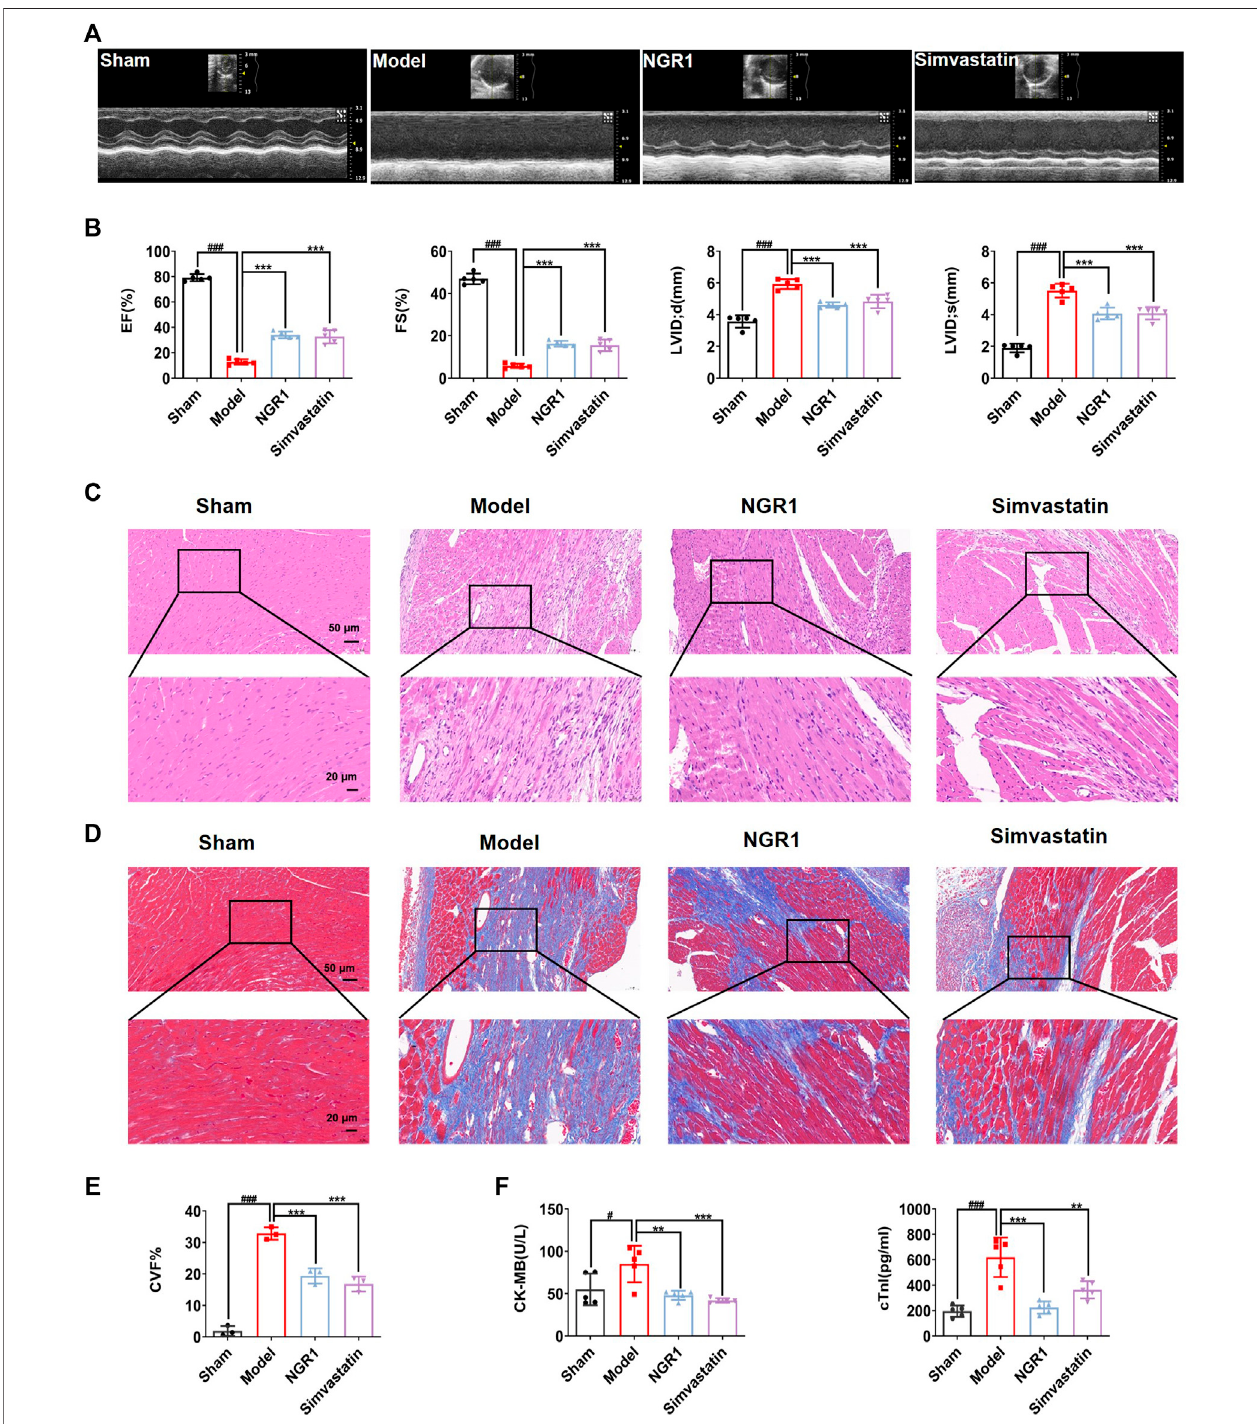
FIGURE 1 | NGR1 treatment enhanced cardiac function and alleviated myocardial pathological changes in the HF mice model. (A) Representative images of 2M- modeechocardiographyinthesham,model,NGR1andsimvastatingroup. (B) Quantitativeanalysisoftheejectionfraction(EF),fractionalshortening(FS),leftventricular internal diameter at end-diastolic (LVID;d) and left ventricular internal diameter at end-systolic (LVID;s). N = 5 per group (C) Representative pictures of H&E staining of each group. Scale bar =20 μ m/50 μ m, N =3per group. (D) Representativepictures ofMasson stainingofeach group. Scalebar =20 μ m/50 μ m, N =3per group (E) Semi-quantitative results of collagen volume fraction (CVF), the formula was CVF = collagen fi ber area/myocardial surface area × 100%. (F) Heart failure biomarkers including CK-MB and cTnI in serum were detected. ** p < 0.01, *** p < 0.001 vs. model group, # p < 0.05, ### p < 0.001 vs. sham group, N = 5 per group.